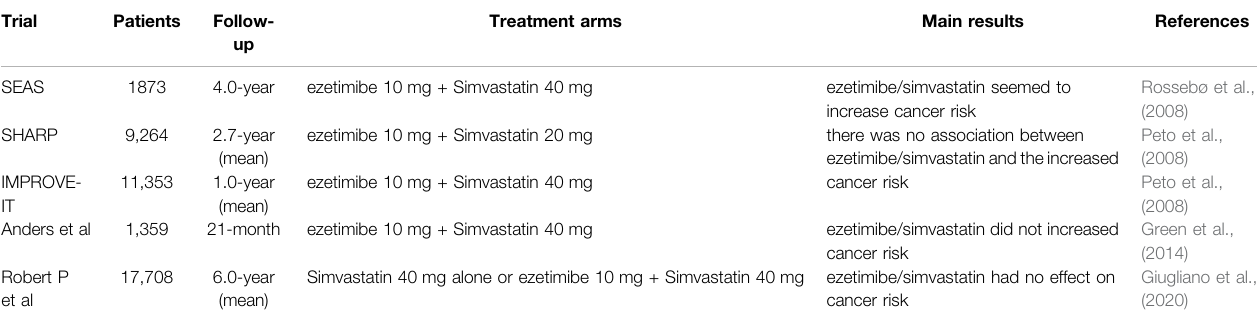
TABLE 2 | Clinical evaluation of ezetimibe on cancer risk. Trial